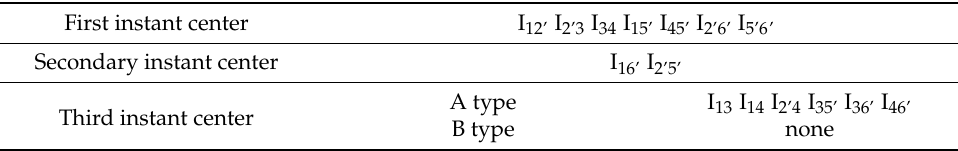
Table 3. Instant centers of Stephenson linkage with the virtual